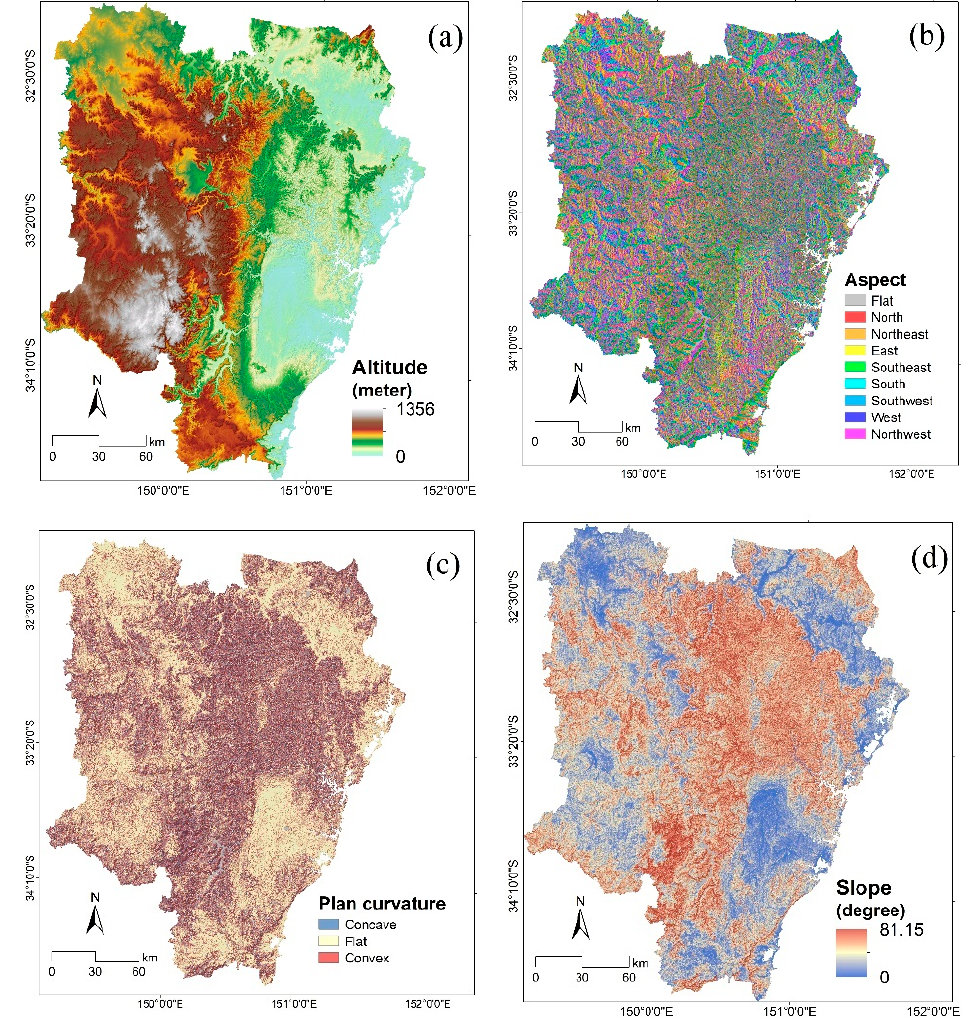
Figure 3. Topographical-related factors: ( a ) altitude, ( b ) aspect, ( c ) plan curvature, and ( d ) slope.